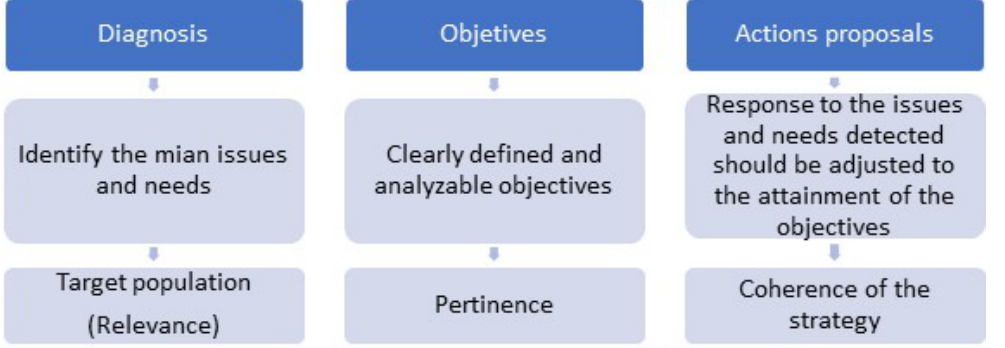
Figure 9. Evaluation of the quality of the design of urban-territorial development strategies, Source: Own elaboration based on CADIPAT PROJECT [38].